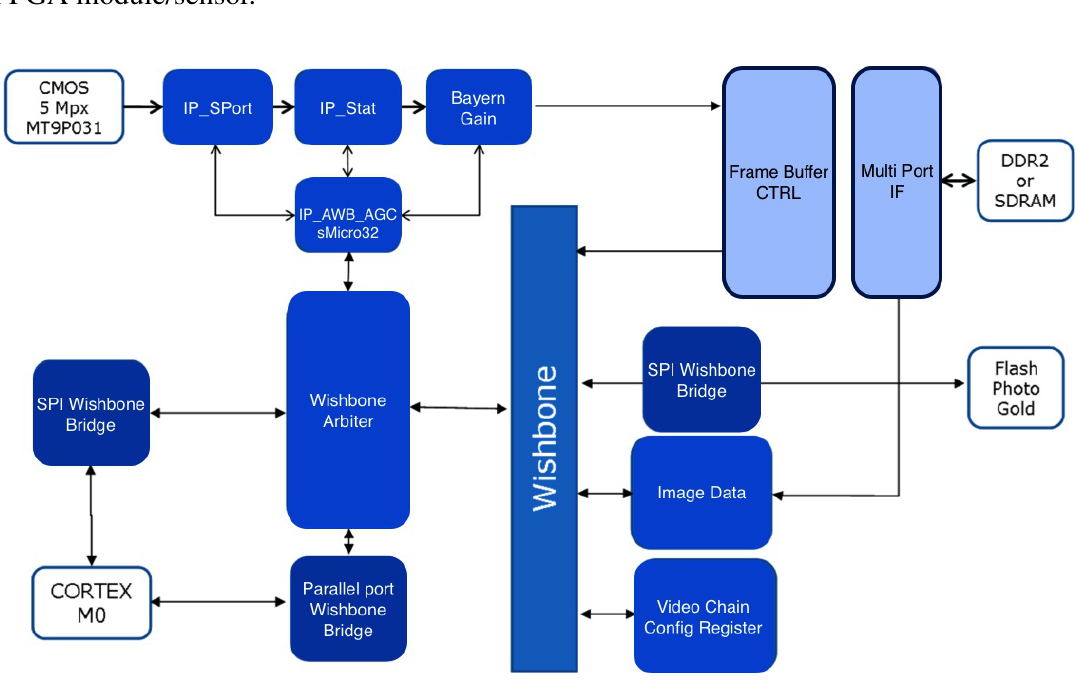
Figure 4. Flowchart of the FPGA